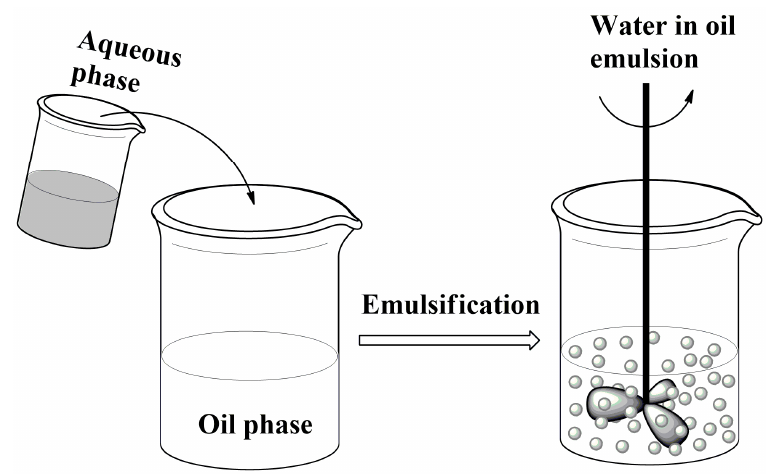
Figure 6. Schematic representation of emulsification process: polysaccharide solution (aqueous phase) is dispersed in oil phase (water-in-oil emulsion) followed by gelation of each individual